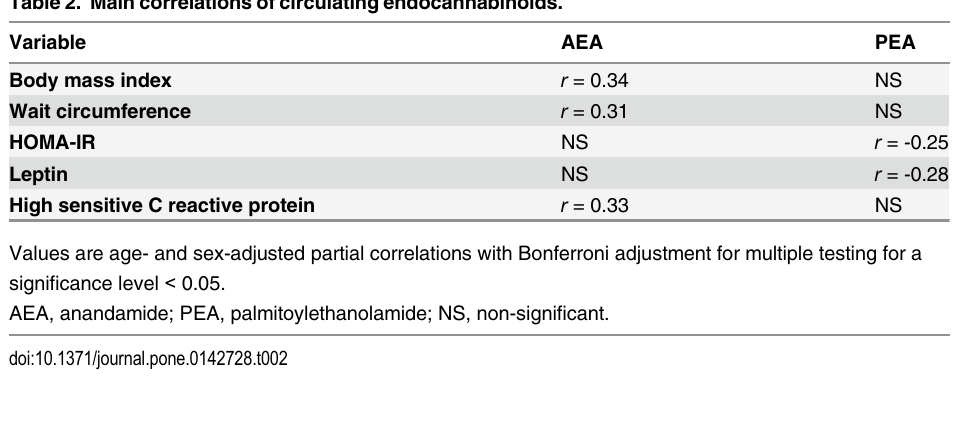
Table 2. Main correlations of circulating endocannabinoids.